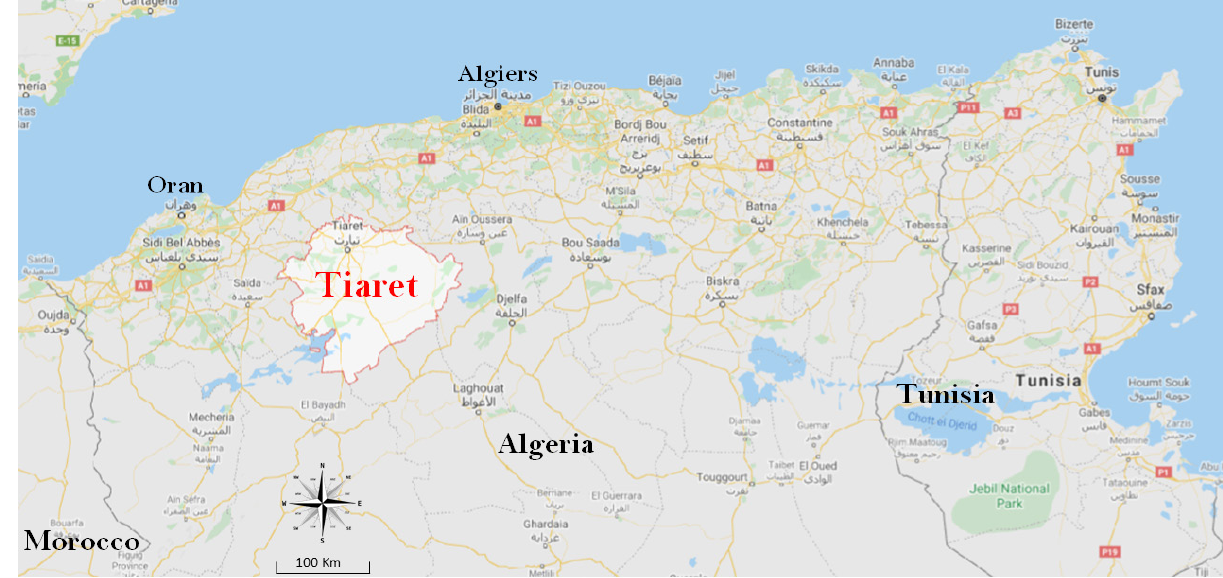
Figure 1. Geographical location of the region of Tiaret, North West Algeria (with red color border filled white) (Google Maps